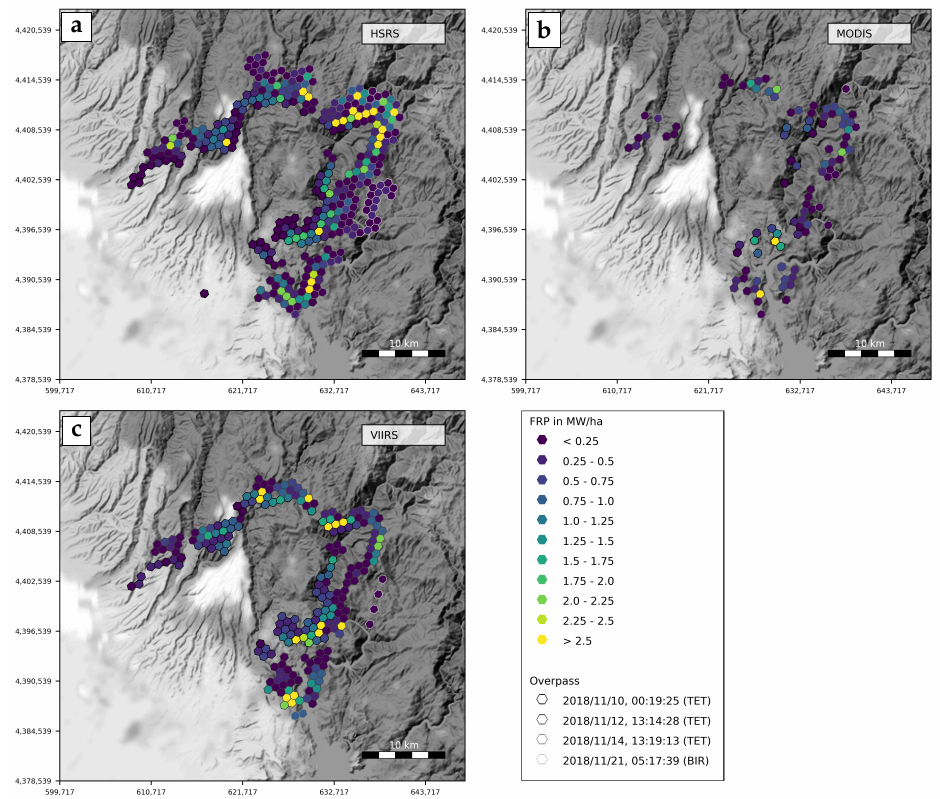
Figure 7. FireBIRD active fire data (derived using the MWIR method) and reference data for a fire event in California/USA, November 2018. ( a ) shows active fires derived from four FireBIRD/HSRS overpasses (10–21 November 2018), pigmented by FRP. ( b ) shows MODIS active fire data of the Aqua/Terra overpasses in closest temporal vicinity to the respective FireBIRD overpasses. ( c ) shows VIIRS active fire data of the Suomi-NPP overpasses in closest temporal vicinity to the respective FireBIRD overpasses. Background: Stamen/OpenStreetMap shaded terrain